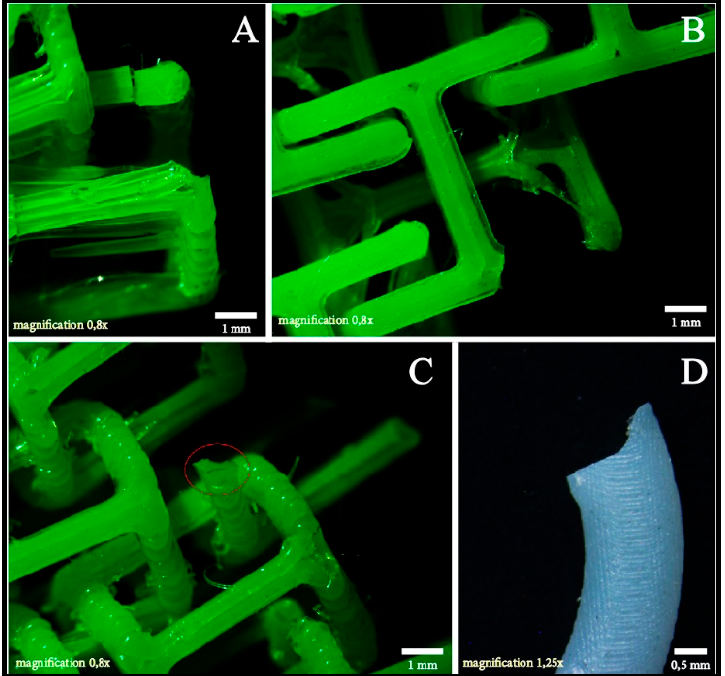
Figure 11 . Microscopic analysis of the fracture zone. ( A ) stress concentration zone for cylindrical elements; ( B ) stress concentration zone for prismatic elements; ( C ) delamination for cylindrical elements; and ( D ) brittle fracture for annular elements.